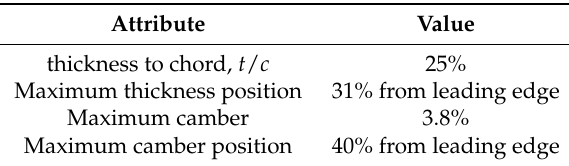
Table 2. Airfoil